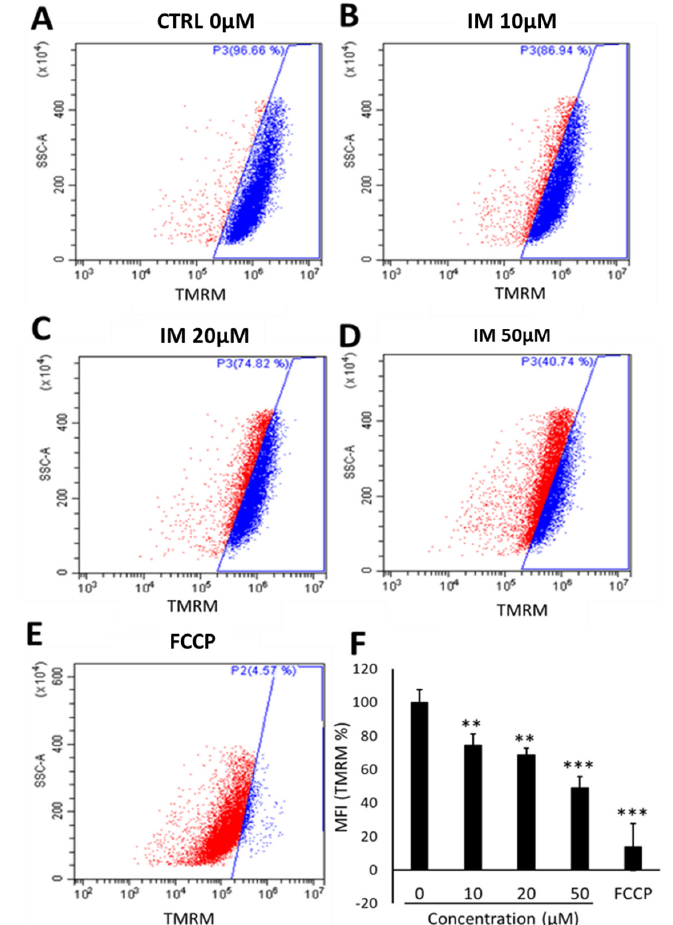
Figure 2. IM reduces hCPC mitochondrial membrane potential. Changes in TMRM fluorescent intensity with increased concentration of IM: ( A ) Control (blue), ( B ) 10 µ M IM with slight left shift in intensity (red), ( C ) 20 µ M IM, ( D ) 50 µ M IM, and ( E ) positive control of 10 µ M FCCP. ( F ) Quantification of mean florescence intensity (MFI) of TMRM normalised against control (100%). Data are mean ± SEM, n = 5; ** p < 0.01 and *** p < 0.001 vs. control.